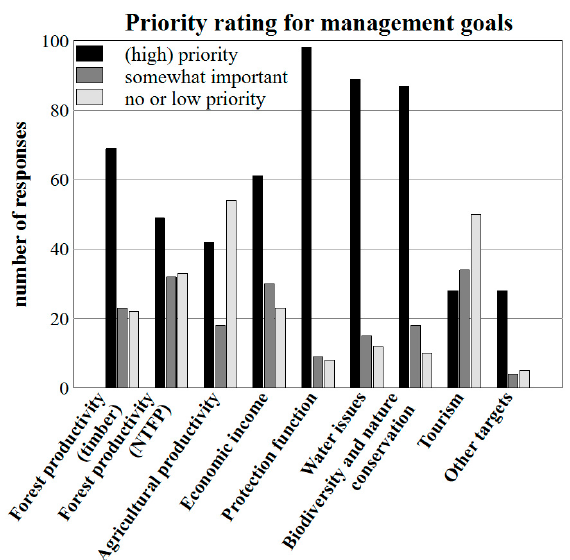
Figure 3. Management targets by different priorities reported in the survey for FLR and combined approaches. NTFP abbreviates Non ‐ timber forest products.